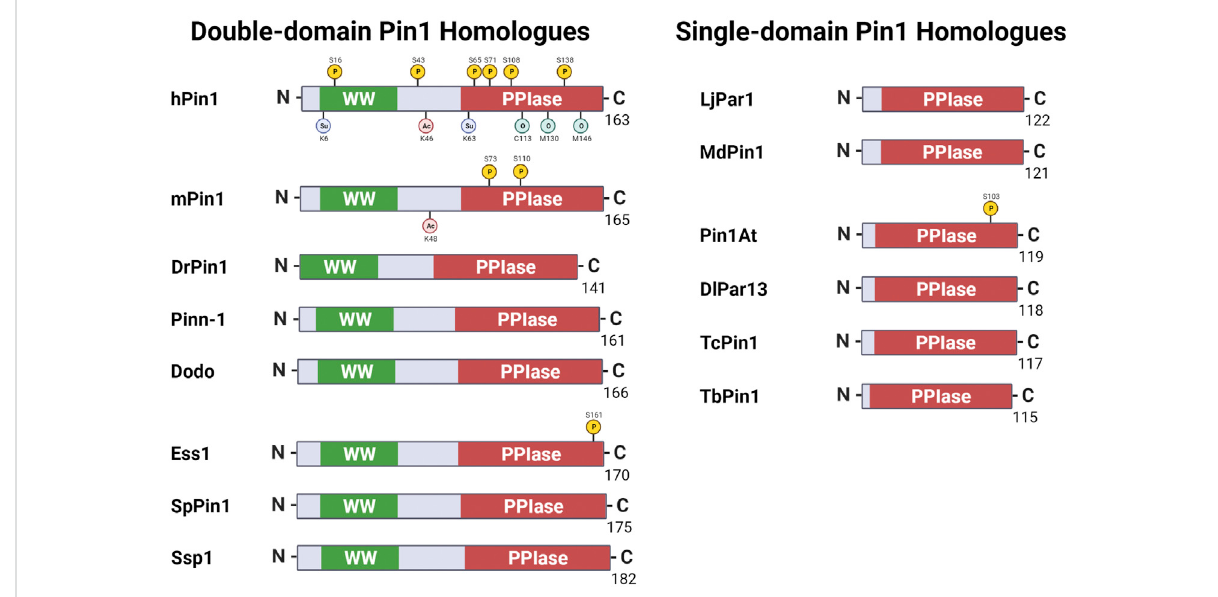
FIGURE 1 Pin1 orthologs across various species. Pin1 orthologs possess either the WW and peptidyl-prolyl isomerase (PPIase) domains or just the single PPIase domains. hPin1: Human Pin1; mPin1: Mouse Pin1; DrPin1: Danio rerio Pin1; Pinn-1: Caenorhabditis elegans Pin1; Dodo: Drosophila melanogaster Pin1; Ess1: Saccharomyces cerevisiae Pin1; SpPin1: Schizosaccharomyces pombe Pin1; Ssp1: Neurospora crassa Pin1; LjPar1: Lotus japonicus Pin1; MdPin1: Malus domestica Pin1; Pin1At: Arabidopsis thaliana Pin1; DlPar13: Digitalis lanata Pin1; TcPin1: Trypanosoma cruzi Pin1; TbPin1: Trypanosoma brucei Pin1. P: phosphorylation; Su: sumoylation; Ac: acetylation; O: oxidation. Created with